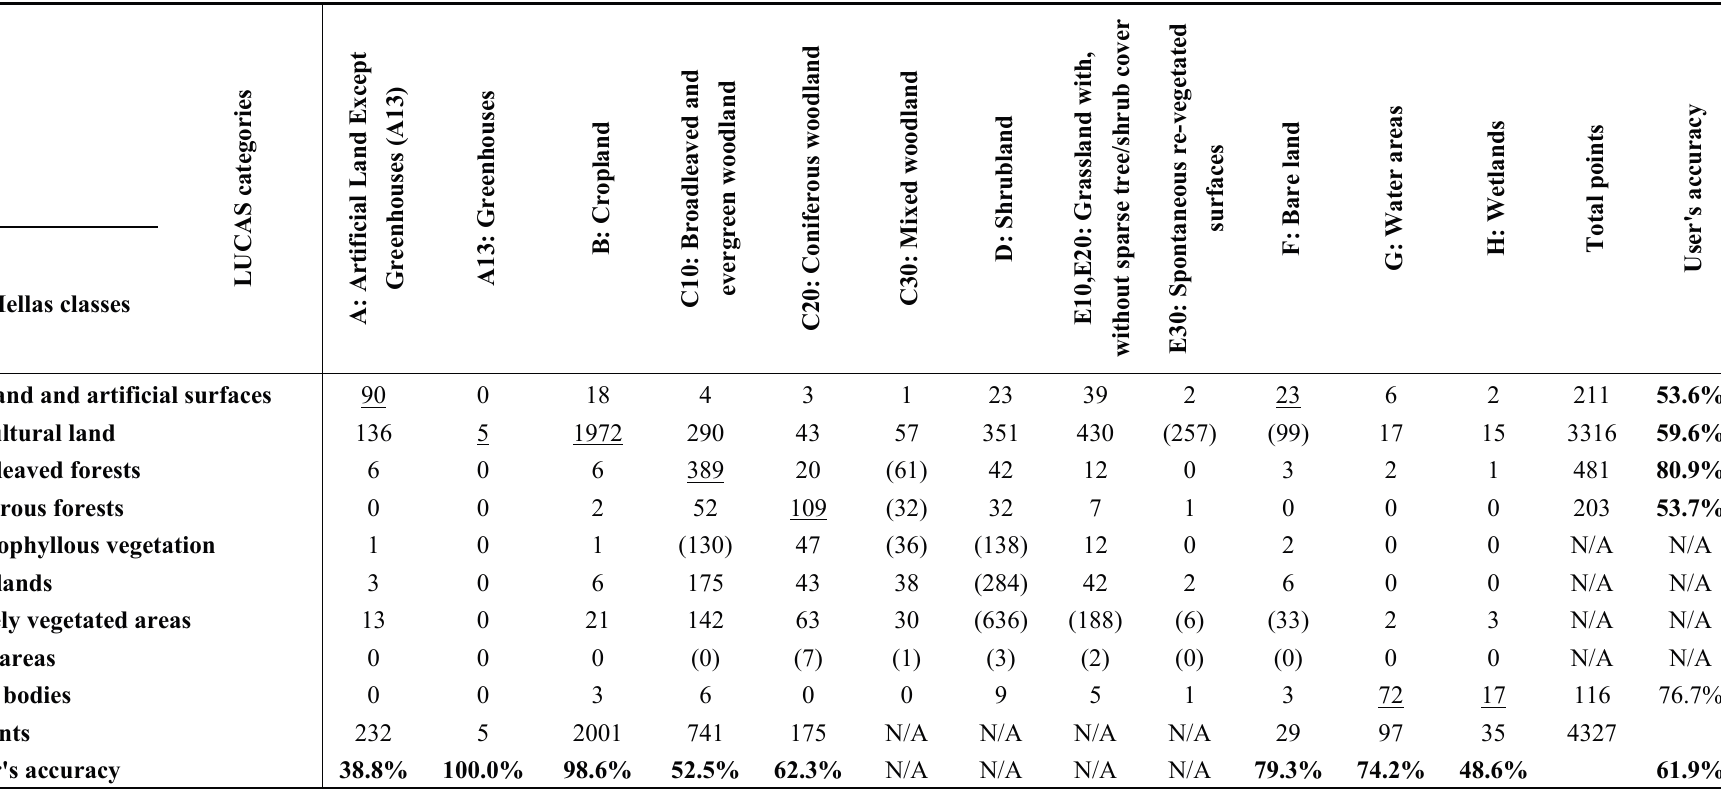
Table 5. The error matrix and accuracy totals of the automated validation process (underlined numbers indicate points resulted from clear relations of agreement; numbers in brackets indicate excluded class